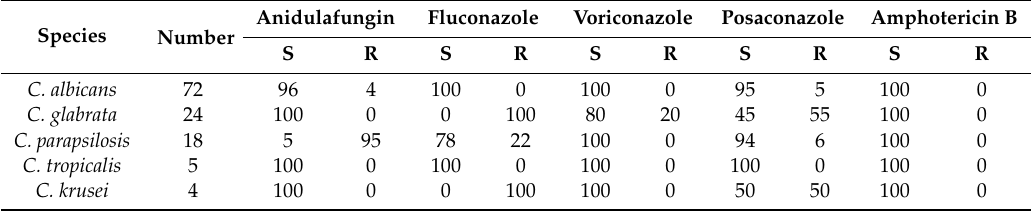
Table 1. Candida species and susceptibility classification (%) according to EUCAST guideline